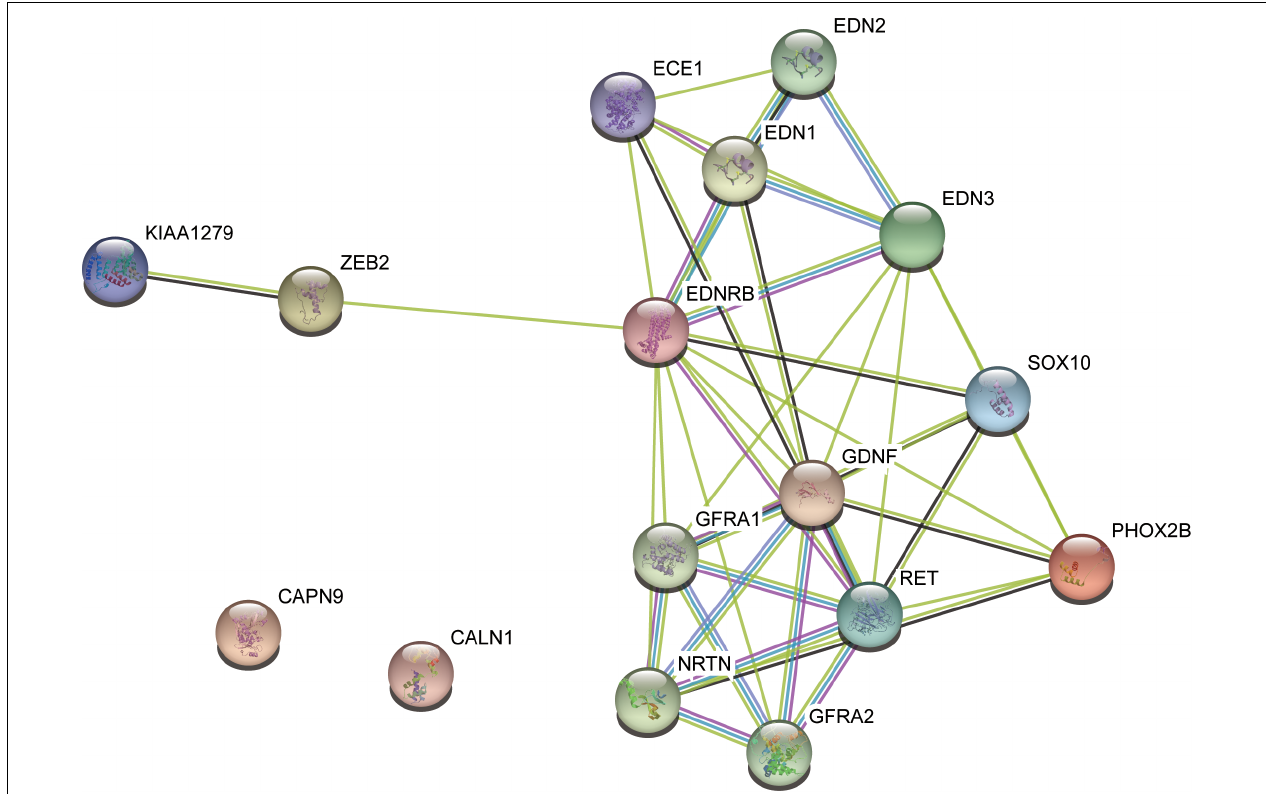
FIGURE 3 | The protein–protein interaction subnetwork of two pathogenic candidates and nine known pathogenic